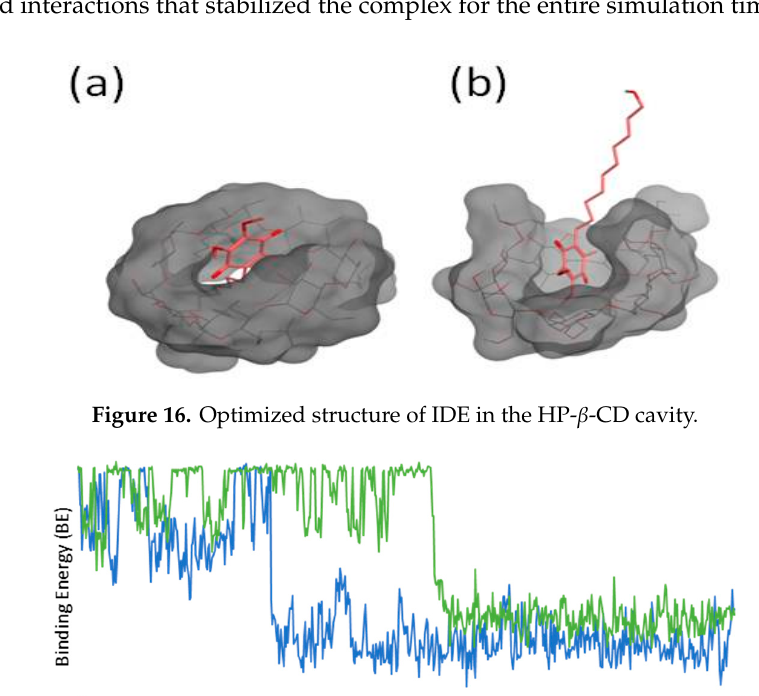
Figure 17. Poisson–Boltzmann binding energy (BE) during the entire time of the molecular dynamics (MD) simulation. Blue line: BE of the model with four 2-hydroxypropyl groups to the O 6 of the CD. Green line: BE of the model with four 2-hydroxypropyl groups to the O 2 of the CD.